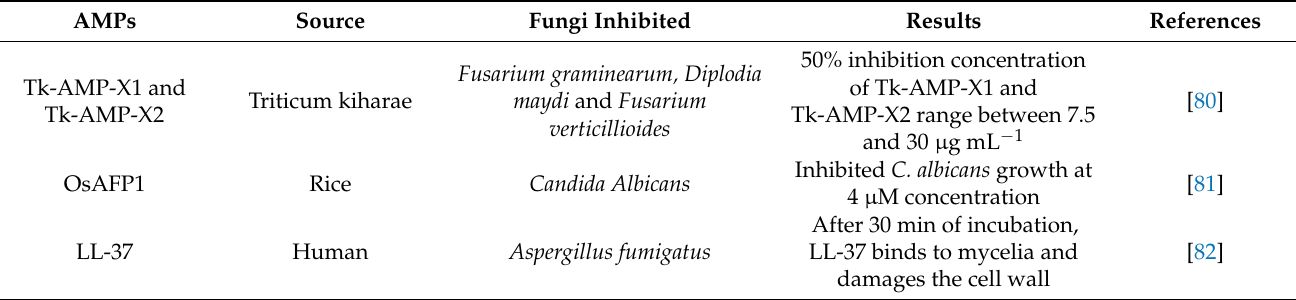
Table 3. List of some of the AMPs with a putative antifungal